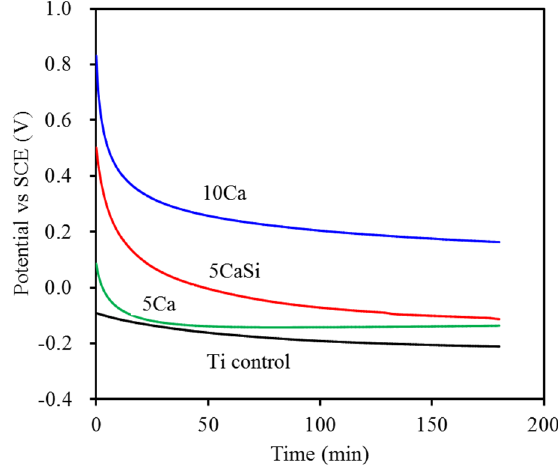
Figure 6. Open circuit potential (OCP) of Ti substrates with and without ion implantation. SCE, saturated calomel reference electrode.